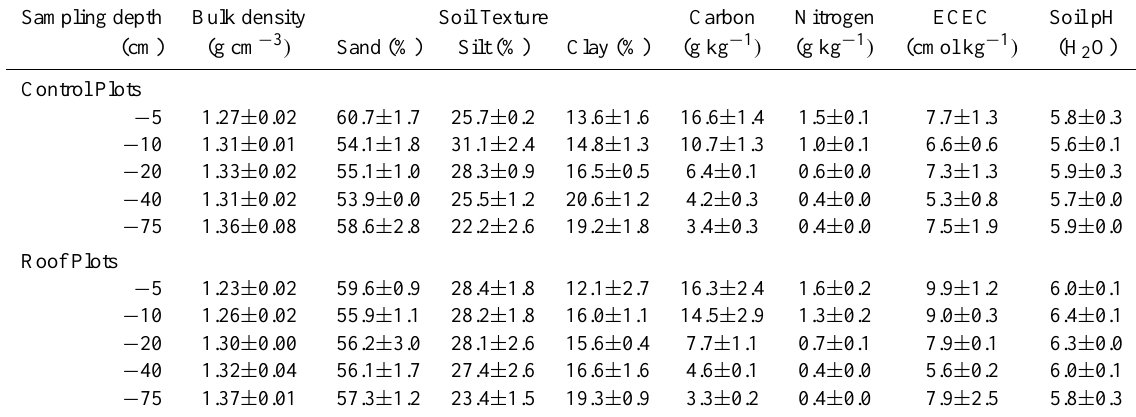
Table 1. Soil physical and chemical characteristics of the cacao agroforestry site in Sulawesi, Indonesia. Sampling depth Bulk density Soil Texture Carbon Nitrogen ECEC Soil pH (cm) (g cm − 3 ) Sand (%) Silt (%) Clay (%) (cmol kg − 1 ) (H 2 O) Control Plots −